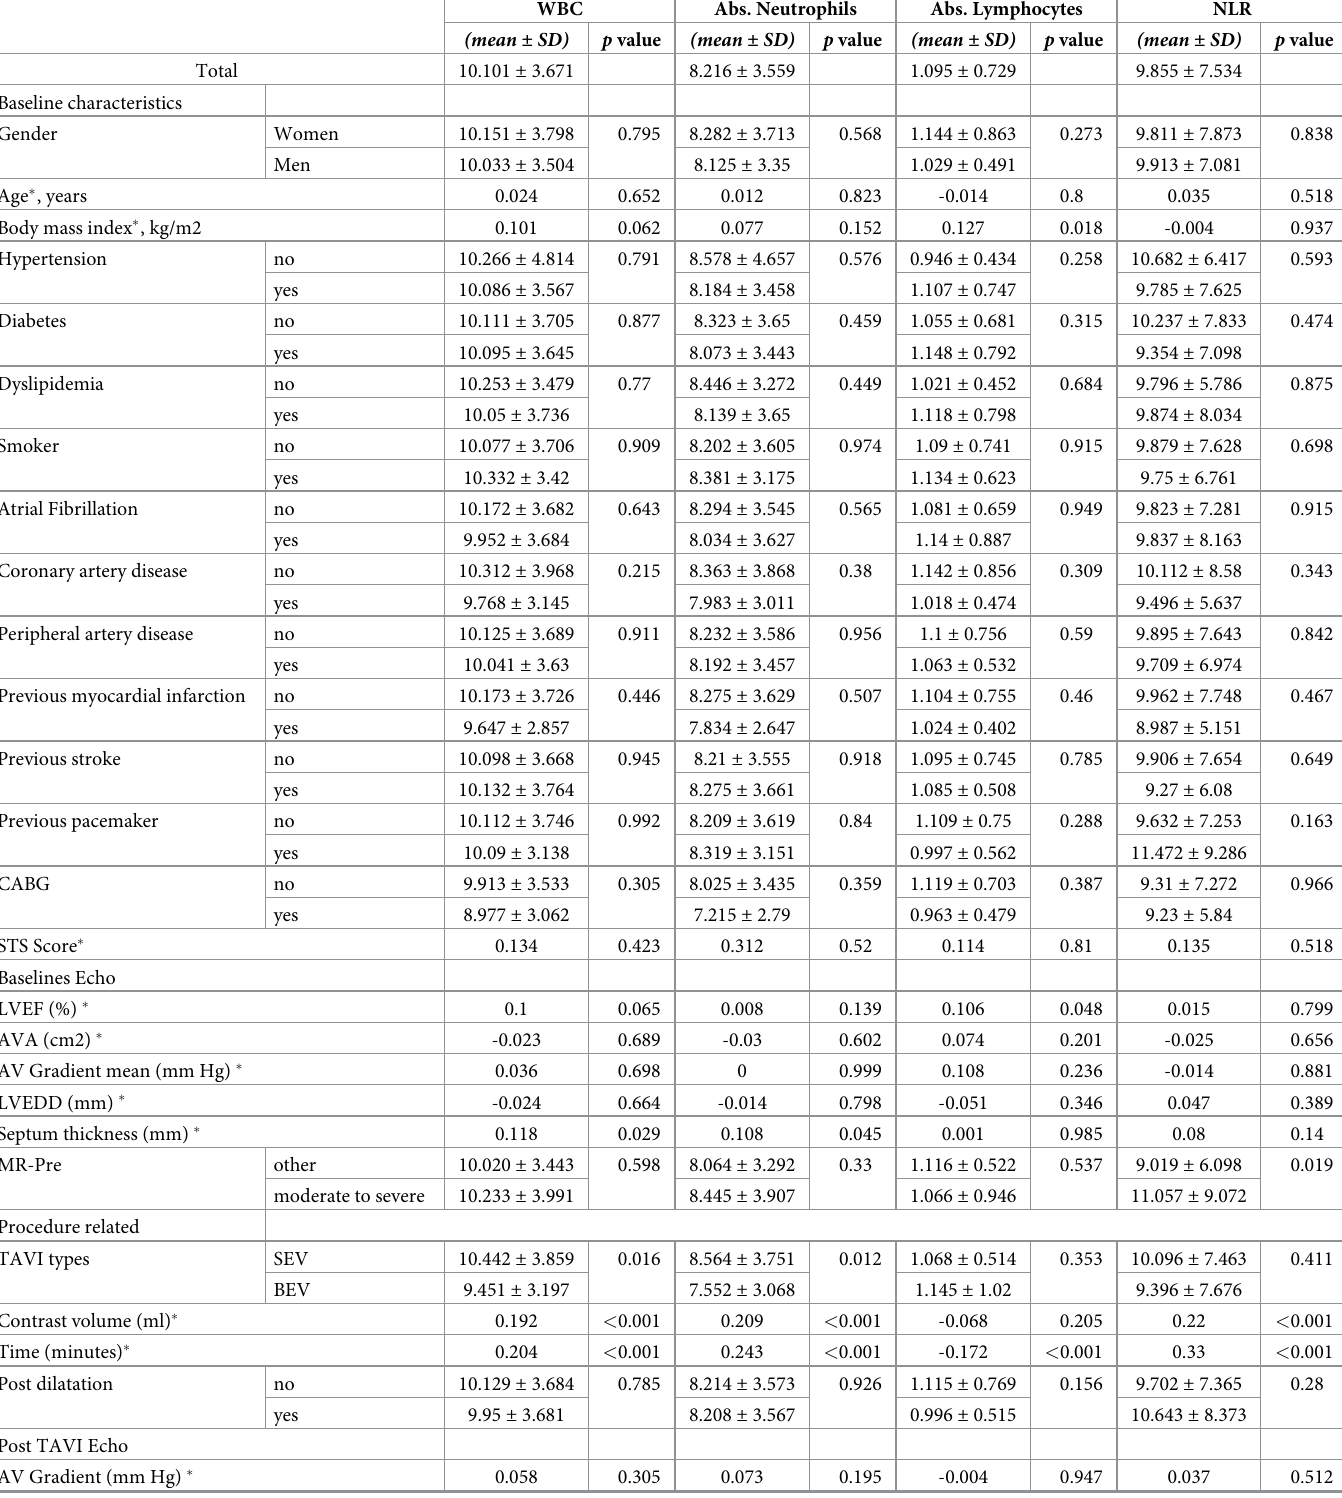
Table 3. Variable analysis of factors that may influence inflammatory markers at 24 hours post TAVI ┼